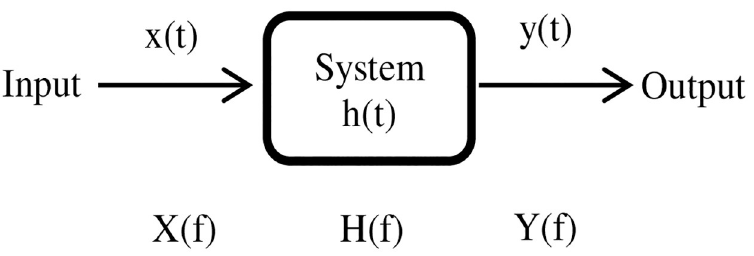
Fig 2. Representation of the transfer function H(f) for the system in time and frequency domain.